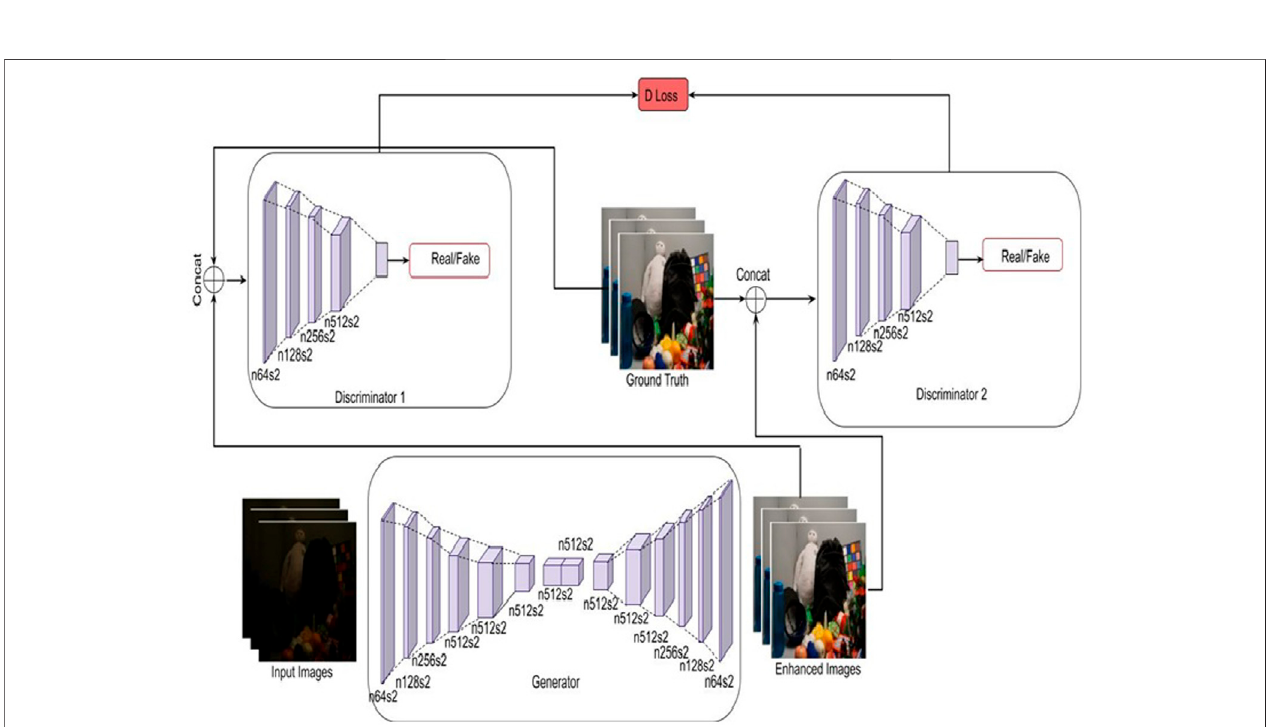
FIGURE 2 | Proposed